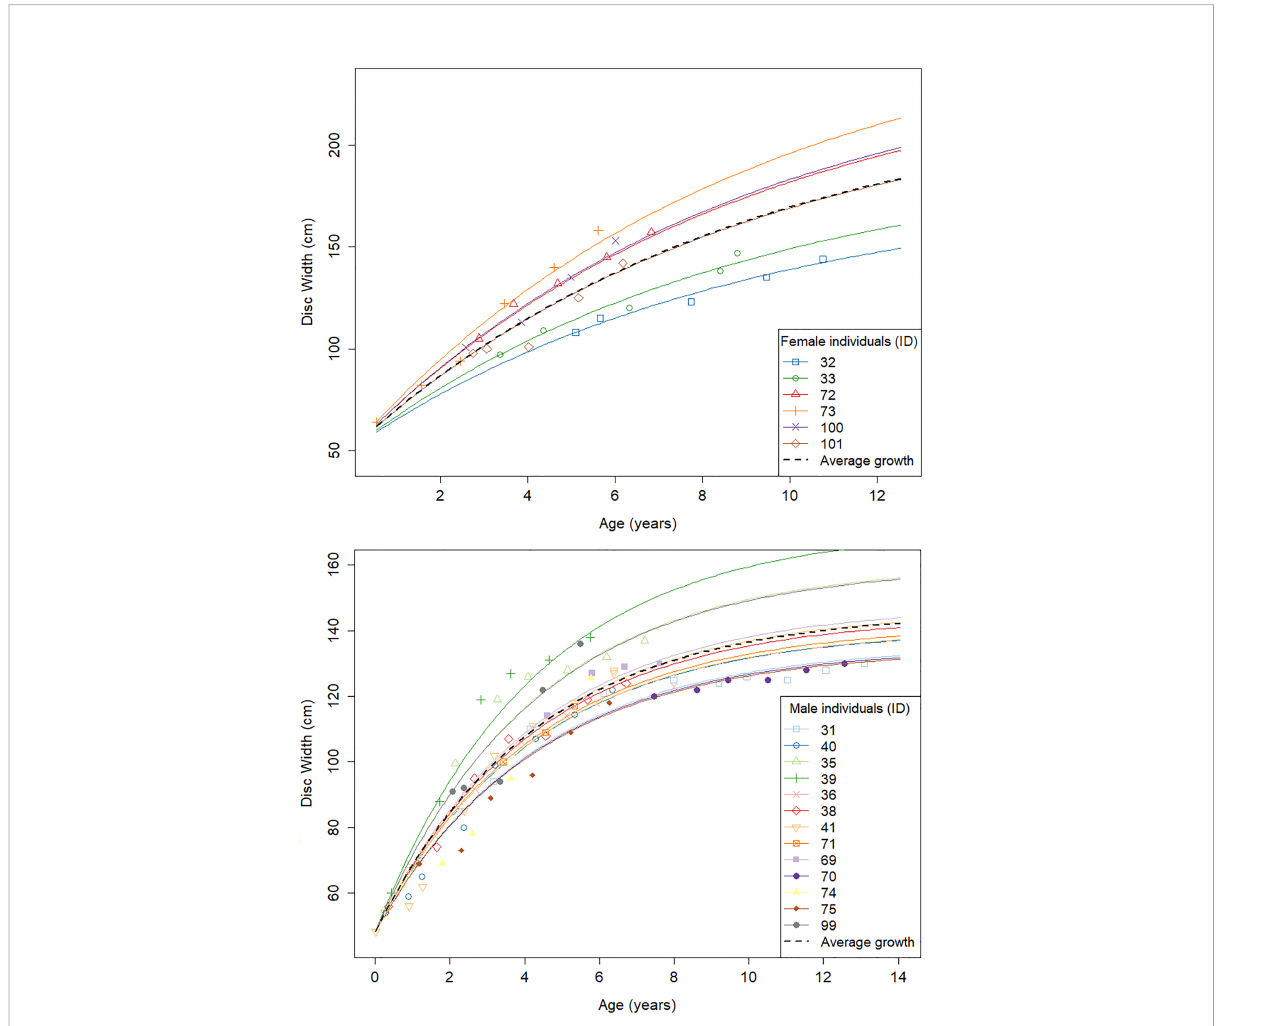
FIGURE 3 Individual von Bertalanffy growth curves for aquarium males (top) and females (bottom) from repeated DW measurements of the same